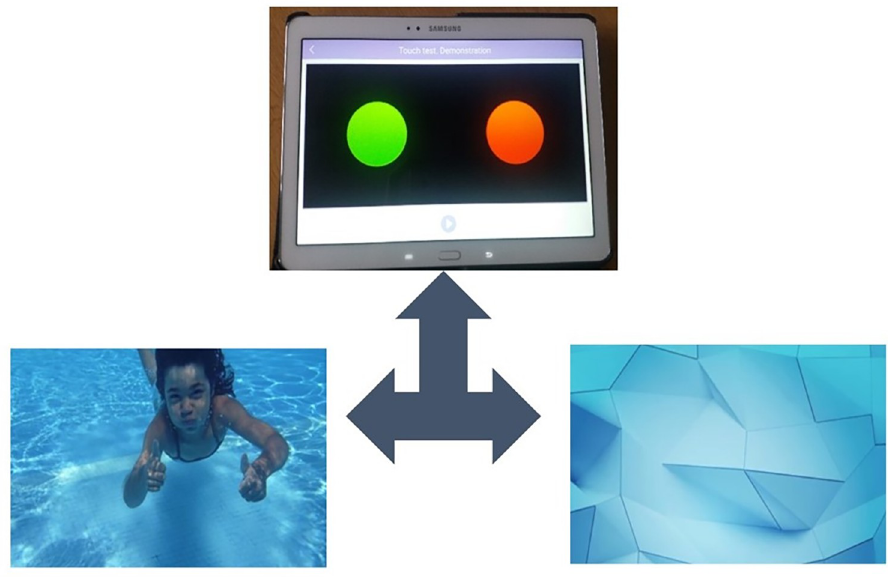
Fig 2. A sample trial from button task showing choice presented on the tablet screen and linked sample of